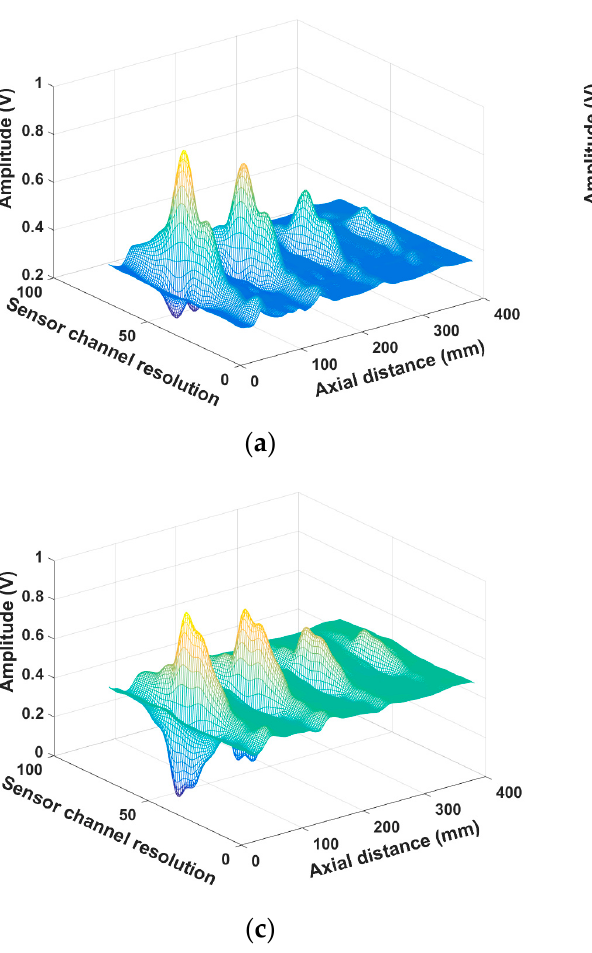
Figure 8. 3D MFL signals after interpolation of 15 channels. ( a ) x axis after interpolation; ( b ) y axis after interpolation; ( c ) z axis after interpolation